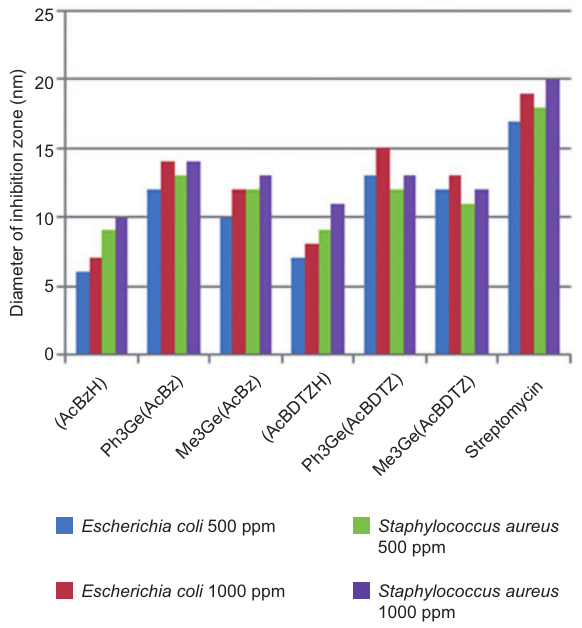
Figure 2 Antibacterial screening of the ligands and their complexes.